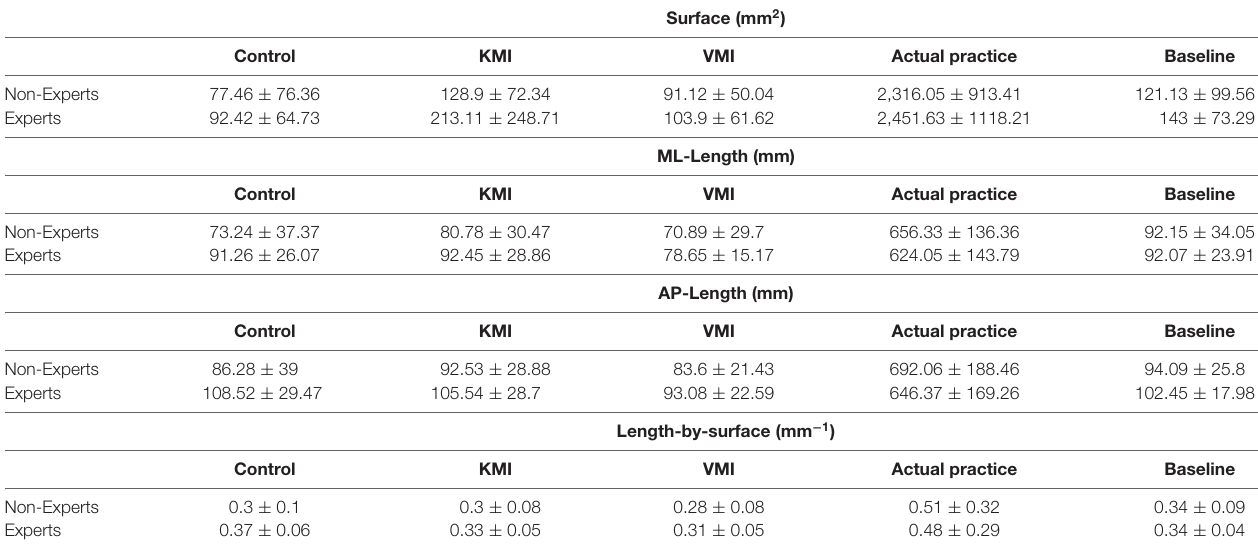
FIGURE 4 | (A) Boxplot summarizing the GROUP effect on subjective ratings of the arabesque performance. (B) Barplot display of the GROUP effect on kinesthetic and visual MI vividness self-reports. (C) Summary of the GROUP effect on VMIQ-2 dimensions. ∗∗∗ p < 0.001. MI: Motor Imagery. TABLE 1 | Raw data before normalization for COP variables recorded in the time